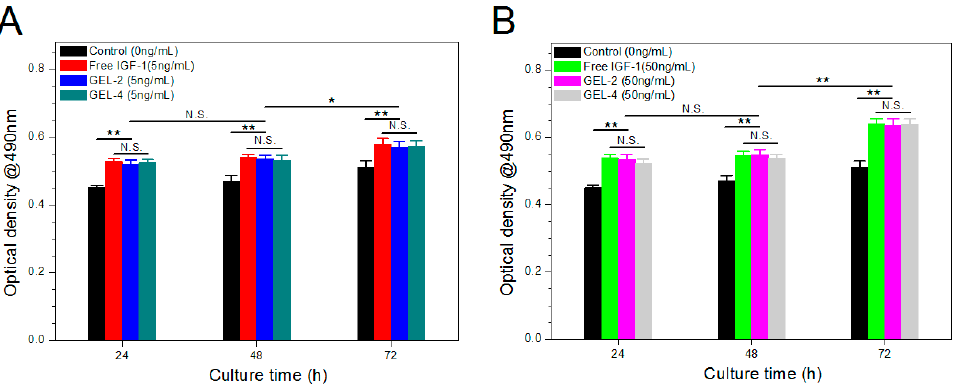
Figure 8. Response of MC3T3-E1 cells to 5 ng / mL ( A ) or 50 ng / mL ( B ) of free or released IGF-1 during various culture periods ( ∗ , p < 0.05; ∗∗ , p < 0.001; N.S., no significance).